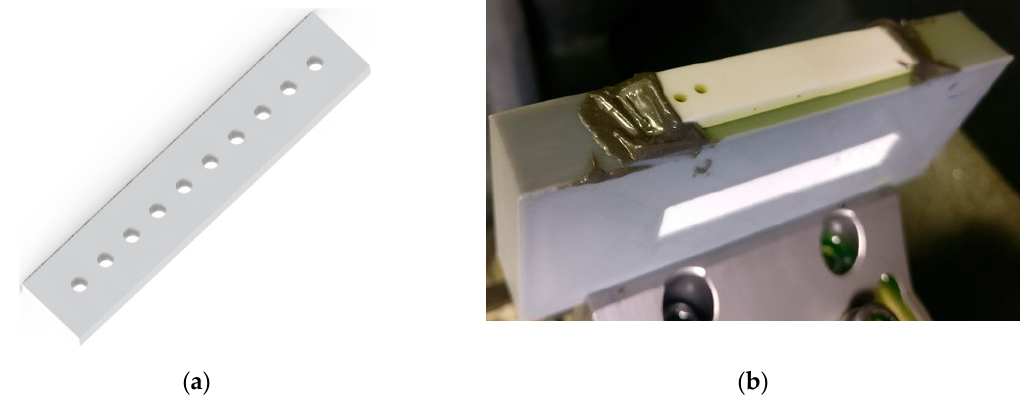
Table 3. Input variable and their levels.